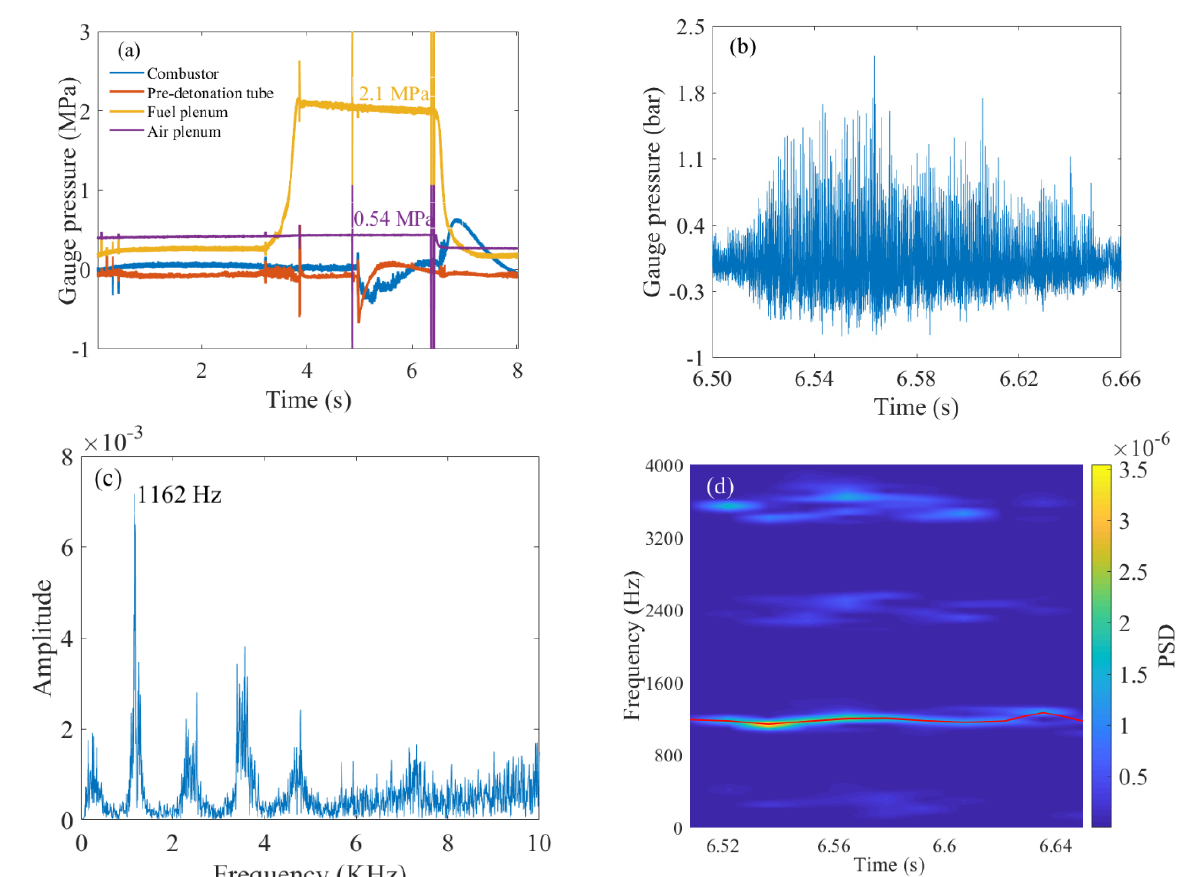
Table 4. Correlation magnitude interpretation [47].